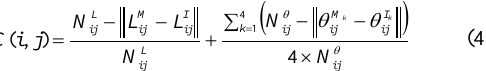
Figure 6. Features Extraction; (a) image and existing building models, (b) image lines (black) and edged corner features (blue) from image, (c) back-projected model (red) and edged corner features (cyan) from manually digitized models and (d) LiDAR- driven models.